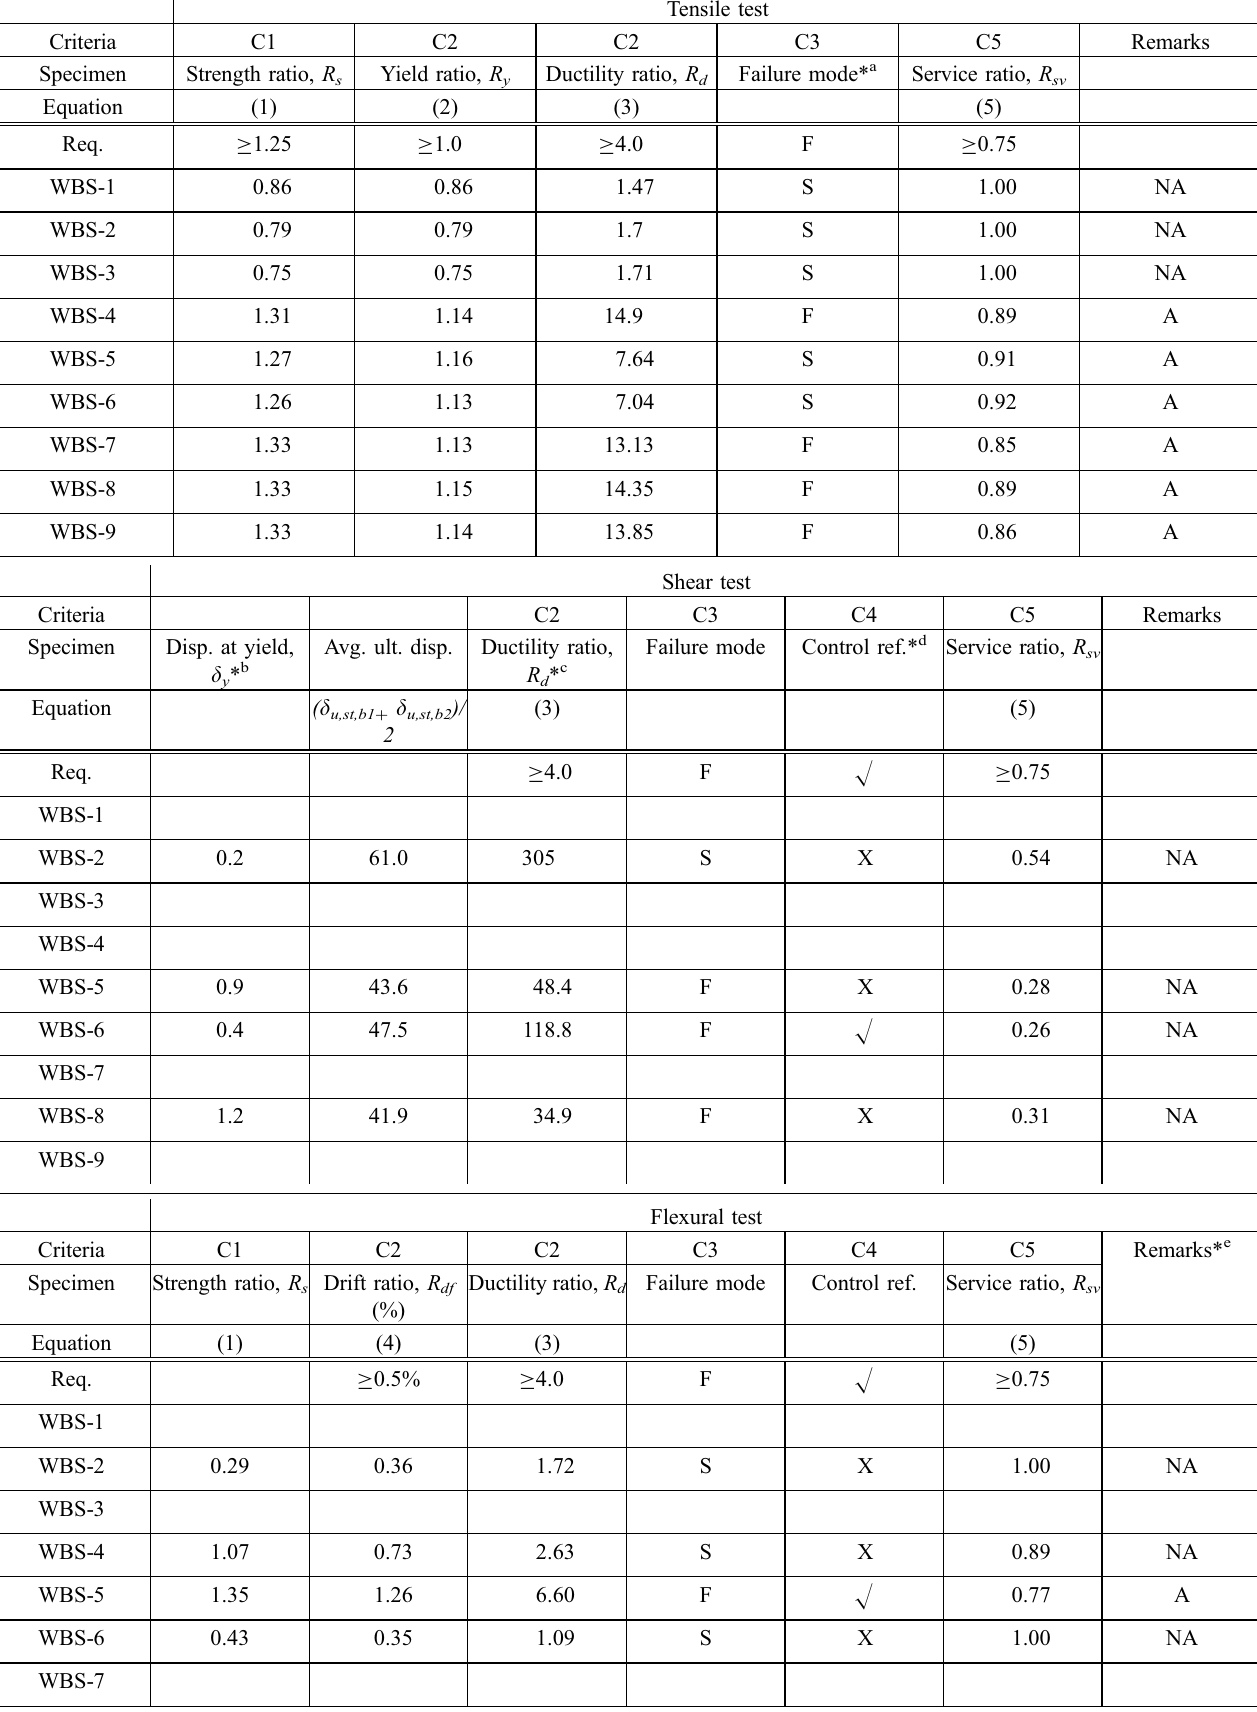
Table 7 Feasibility evaluation of the grouted splice connection in accordance to assessment criteria, with respect to each load